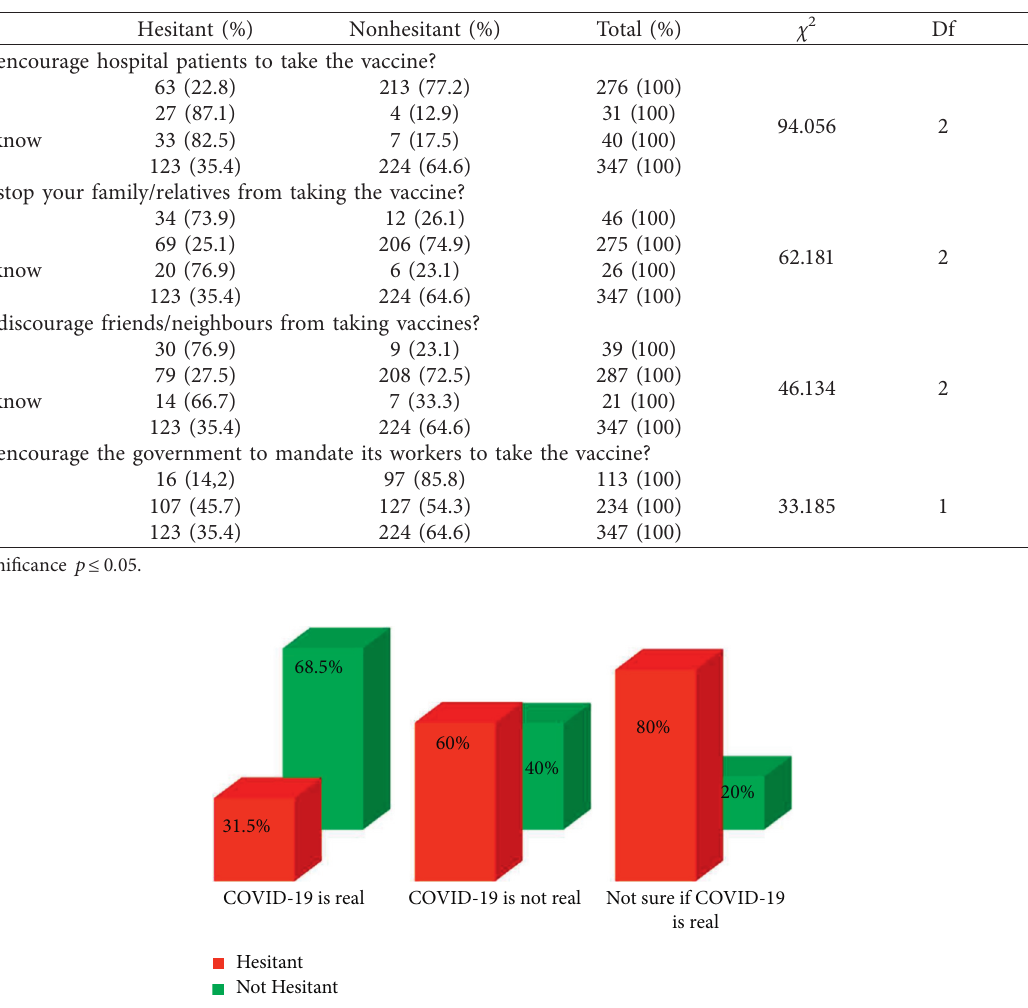
Table 2: Vaccine uptake intention to practice and vaccine hesitancy among HCWs in Imo State, Nigeria.